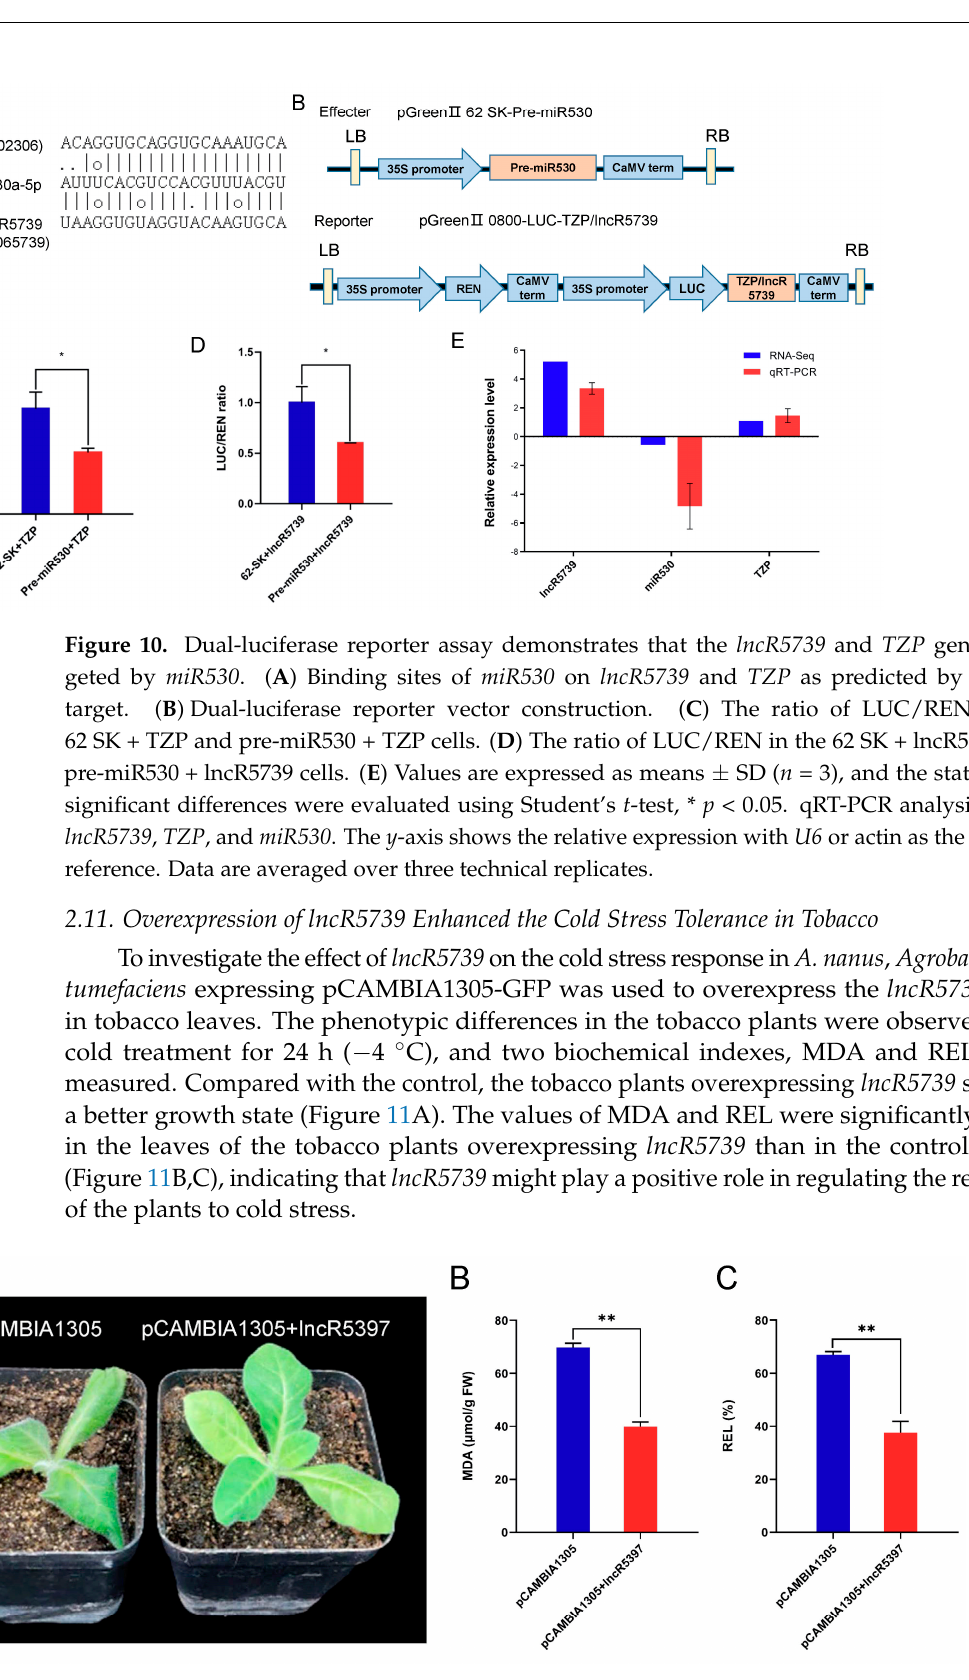
Figure 11. Phenotype analysis of transient overexpression of lncR5739 in tobacco infiltrated by Agrobacterium tumefaciens . ( A ) The growth state of the control and tobacco plants overexpressing lncR5739 . ( B ) The content of MDA. ( C ) REL values. Values are expressed as means ± SD ( n = 3), and the statistically significant differences were evaluated using Student’s t -test: ** p <